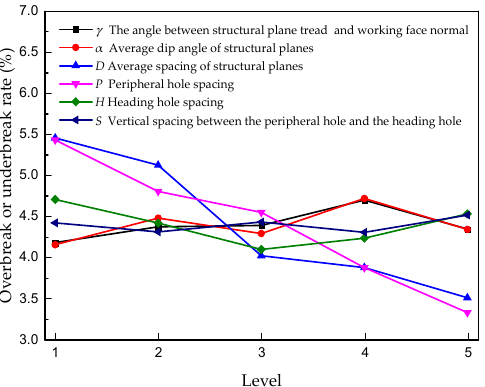
Figure 11. Overbreak or underbreak rate of smooth blasting under different levels of each factor in the massive integrity structure rock mass.